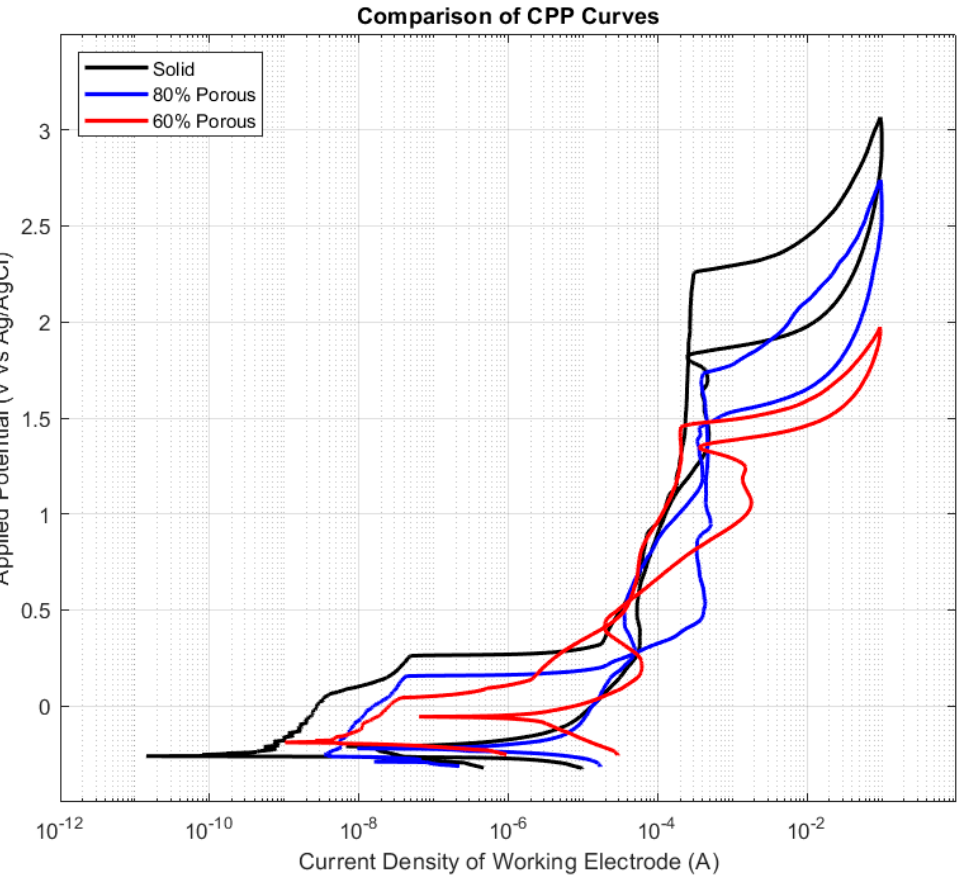
Figure 3. Comparison of example cyclic polarisation curves with solid samples shown in black; 80% porous gyroid sample shown in blue; 60% porous gyroid sample shown in red. All sample results were normalised to match the solid sample’s theoretical surface area of 351.6 mm 2 . Highest breakdown and vertex potentials observed in solid samples followed by 80% then 60%.